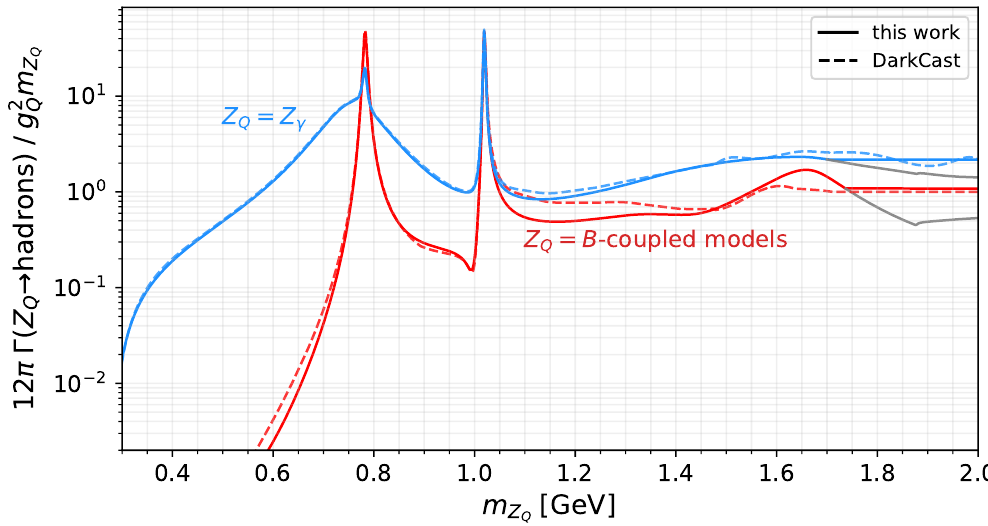
Figure 5 . Comparison of the total hadronic width (solid lines) for the dark photon and B -coupled (baryophilic) Z models with the ones implemented in DarkCast (dashed lines). Around m Q